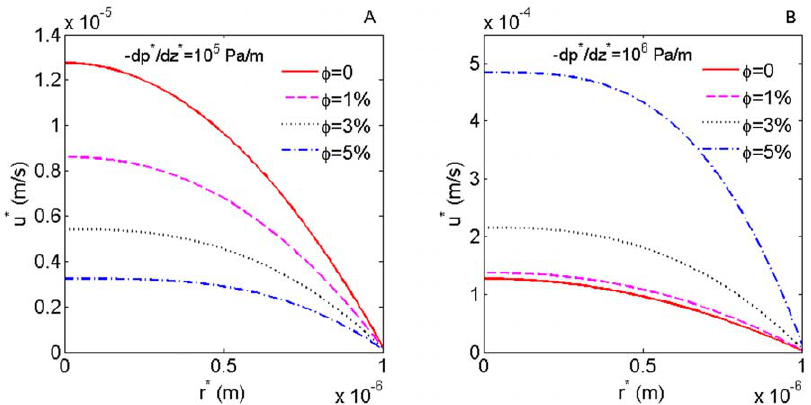
Figure 2. The velocity profiles for different nanoparticle volume fraction and pressure gradient. ( A ) The velocity profiles for w ~ 0, 1%, 3% and 5% with the pressure gradient equaling 10 5 Pa/m. ( B ) the velocity profiles for w ~ 0, 1%, 3% and 5% with the pressure gradient equaling 10 6 Pa/m. doi:10.1371/journal.pone.0037274.g002 PLoS ONE |